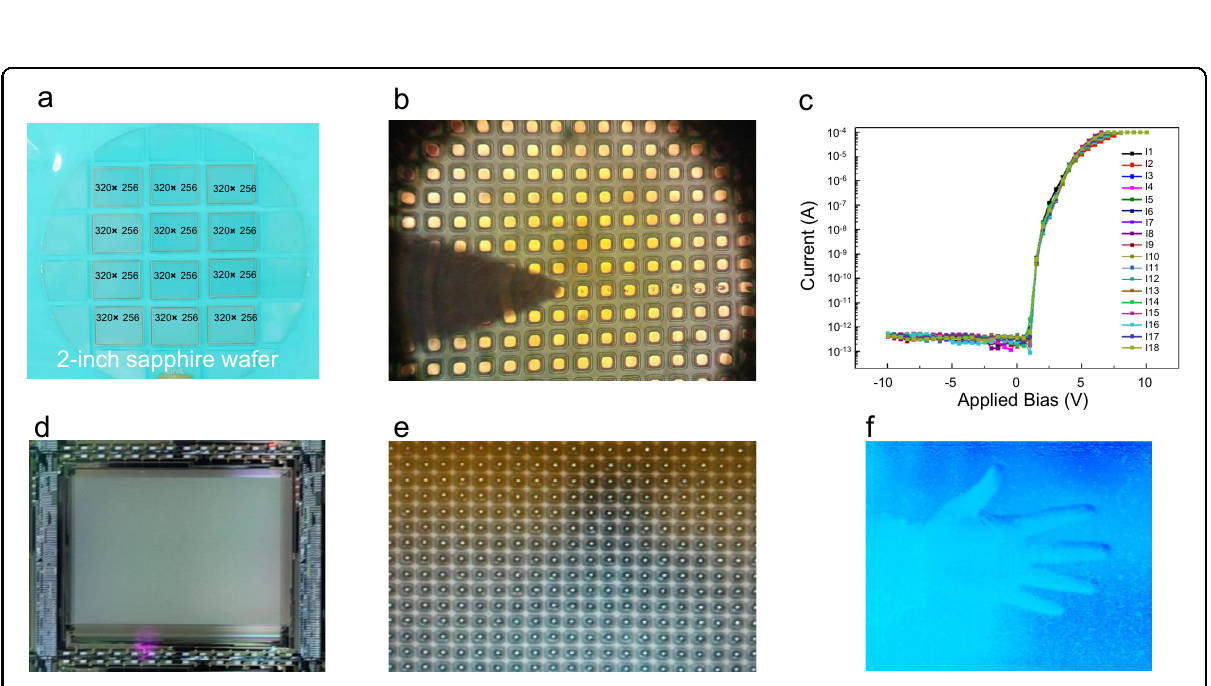
Fig. 19 AlGaN p-i-n solar-blind UV FPAs and imaging by Nanjing University. a 320 × 256 AlGaN FPAs on 2-inch sapphire wafer. b Optical images of AlGaN focal plane arrays. c I-V characteristics of individual photodetector. d Silicon driver IC. e Optical images of array with Indium bumps. f Solar- blind ultraviolet images taken from the AlGaN FPA